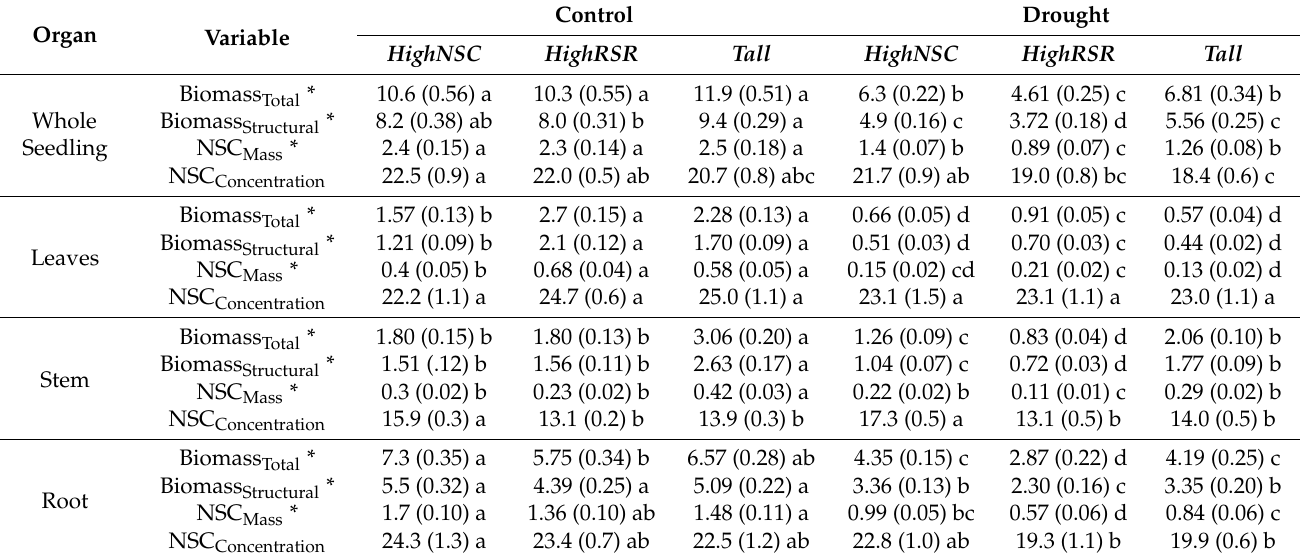
Table A3. Summary of final measurement means ( ± SE) for aspen seedlings by seedling type and drought interaction. Biomass Total is the sum of structural and NSC mass. Different letters within a row indicate significant differences according to Tukey’s HSD ( p ≤ 0.10).